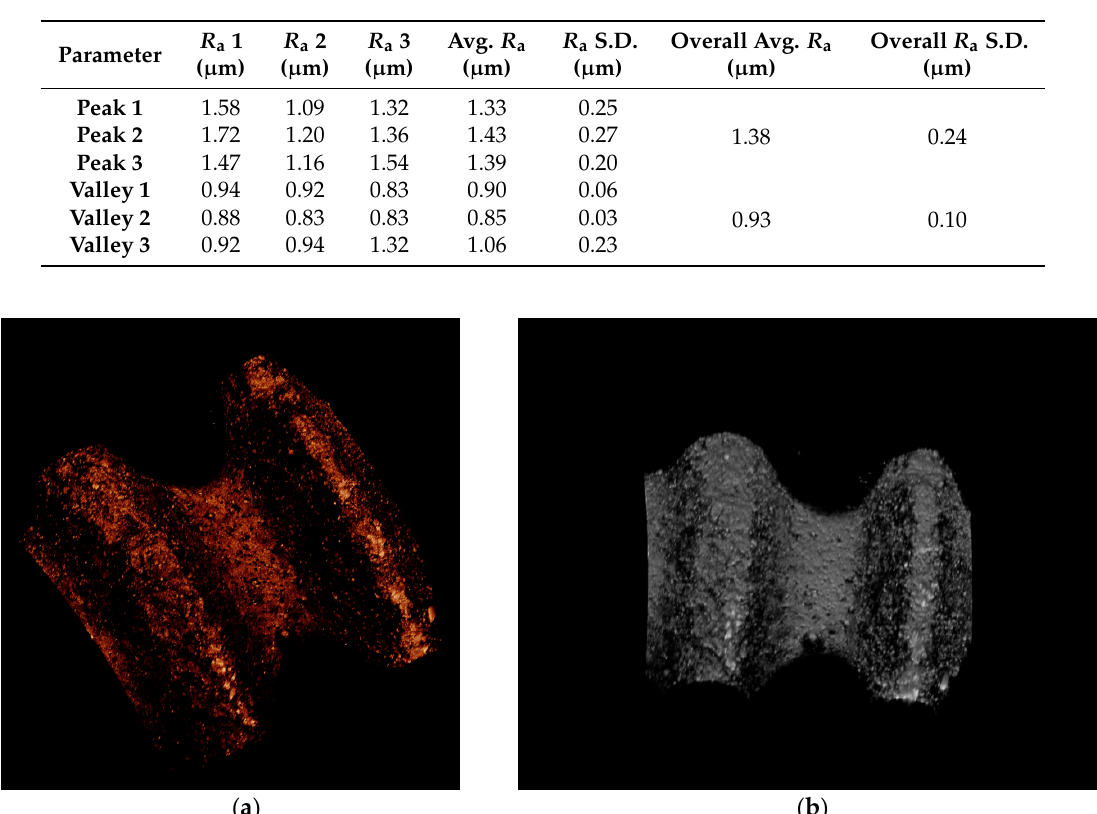
Figure 4. 3D profiles of a ZCE-A implant surface at different angles. ( a ) oblique view and ( b ) front view.